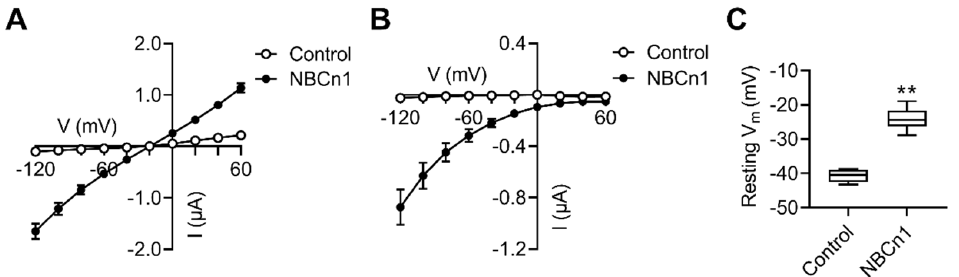
Figure 1. NBCn1 channel activity. ( A ) I–V relationships in oocytes expressing NBCn1 or water-injected control oocytes. Oocytes were subjected to step-voltage commands from –120 to +60 mV (20 mV steps) in CO 2 /HCO 3 − -free ND96 solution ( n = 5–7/group). The increased slope of the I–V plot is a hallmark for NBCn1 channel activity. ( B ) I NBCn1 –V relationship of NBCn1 channel activity. The plot was obtained from the difference between the I–V plots in the presence and absence of bath Na + . ( C ) Resting membrane potentials (V m ). V m was measured 48–72 h after cRNA injection ( n = 5 controls and 16 NBCn1). ** p < 0.01, Student t -test.